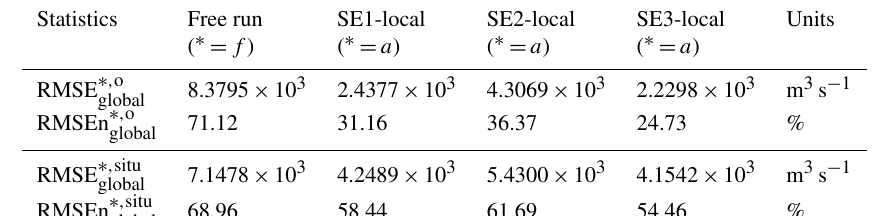
Table 6. Global statistics for experiments with different types of control variables.